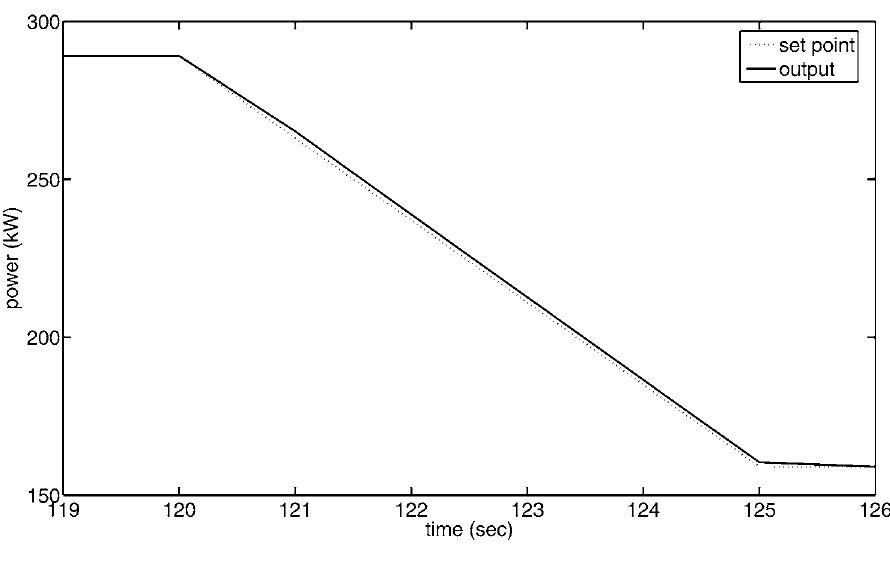
Figure 6. Output power during power set point changes in